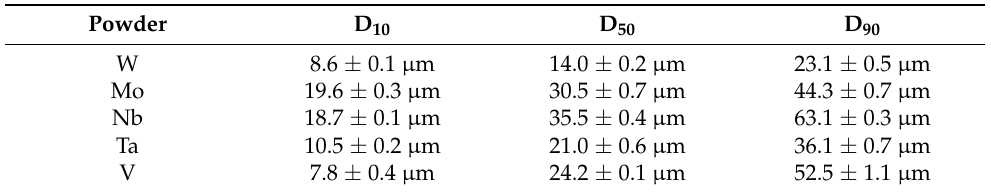
Figure 1. SEM-images of the metal powders used for in-situ alloy formation; W, Mo and Ta powder plasma atomized, Nb powder argon atomized, V powder milled. Table 1. Particle size distribution of the powders used for in-situ alloy formation; determined by laser diffraction; mean value with standard deviation from five single